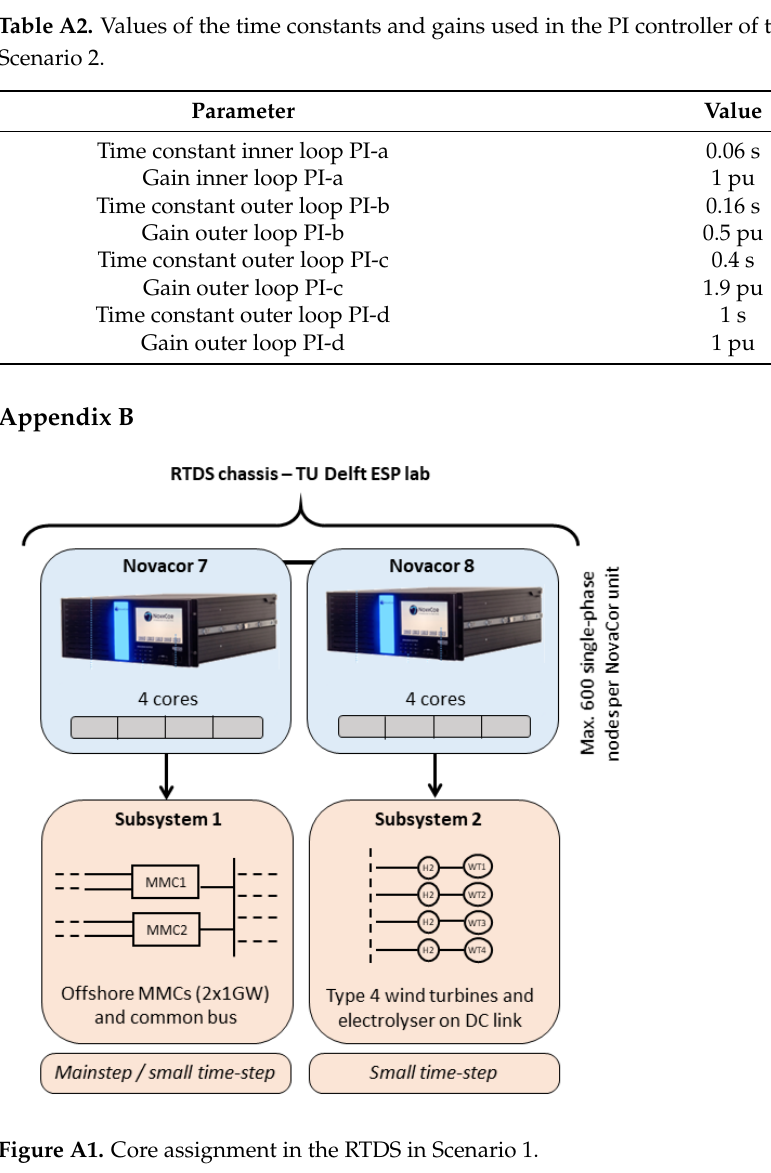
Figure A1. Core assignment in the RTDS in Scenario